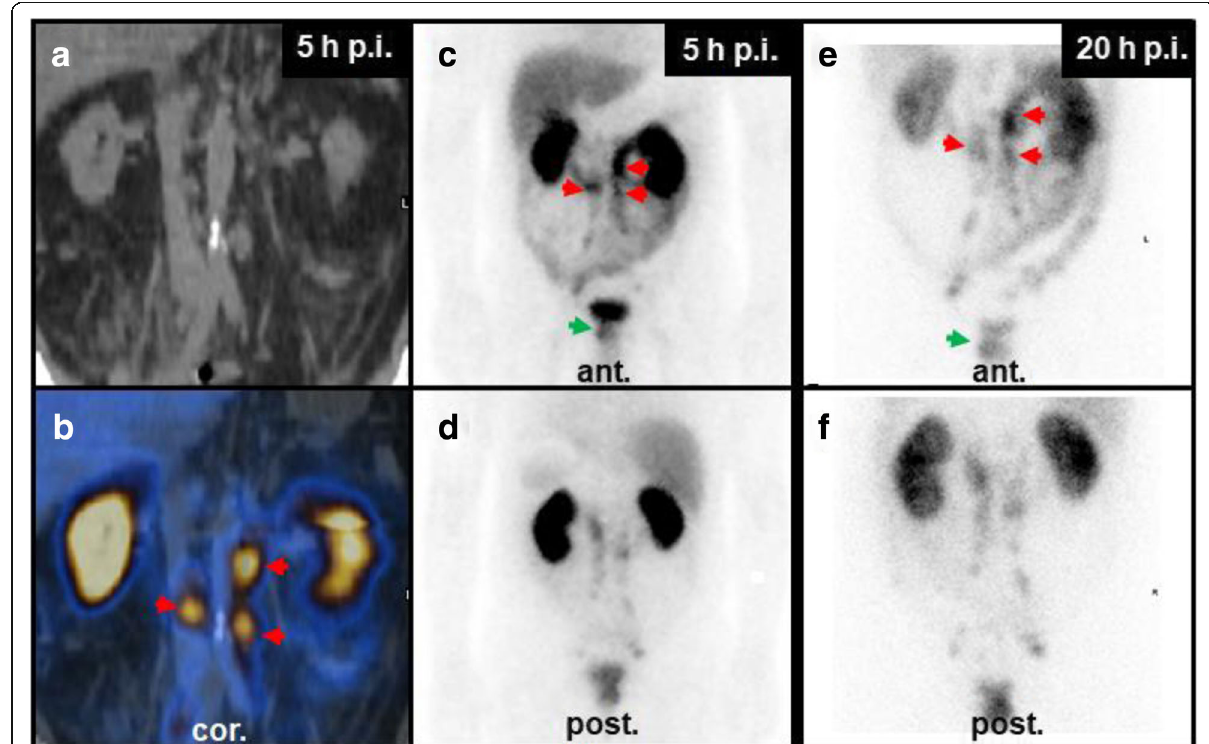
Fig. 1 SPECT/CT at 5 h post injection (p.i.) and pairs of ventral/dorsal planar images at 5 h and 20 h p.i. of [ 99m Tc]Tc-PSMA-I&S. a , b SPECT/CT suggested paraaortic lymph node metastases, but the planar scintigraphy ( c , d ) shows significant hepatobillary and gastrointestinal uptake and suggests urinary secretion. To further distinguish between tumor uptake in paraaortic lymph nodes and unspecific uptake in the ureter (red arrows), a late planar image was taken. e , f Planar scintigraphy at 20 h p.i. Paraaortic uptake remained high and was thus classified as lymph node metastases (red arrows). Note: there was a tracer accumulation in the primary tumor over time, resulting in a better contrast between unspecific bladder signal and the [ 99m Tc]Tc-PSMA-I&S uptake in the prostate (green arrows). Late imaging was restricted to a single bed planar scintigraphy because the low activity at 20 h p.i. would have led to inappropriately high examination times (~ 60 min for planar whole body scintigraphy and whole body